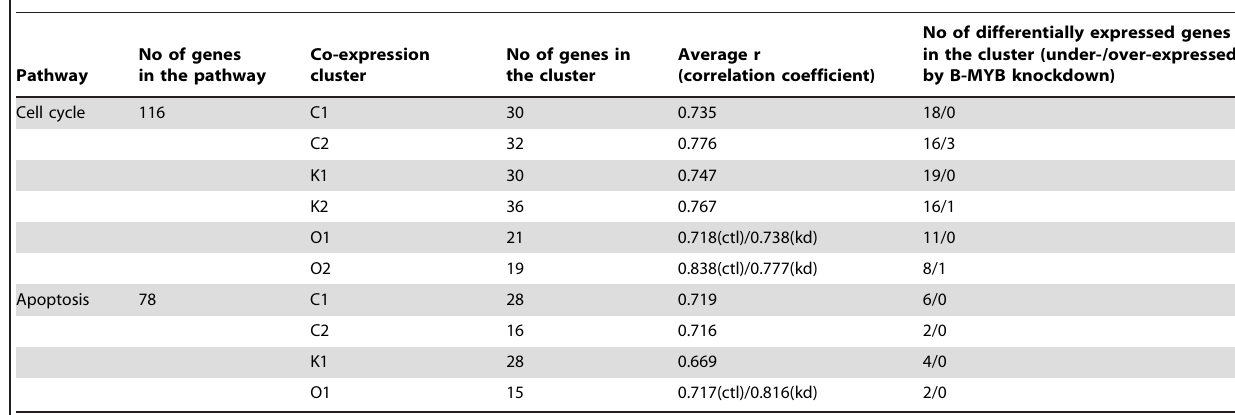
Table 2. Identification of co-expression gene clusters in ES cell critical pathways.